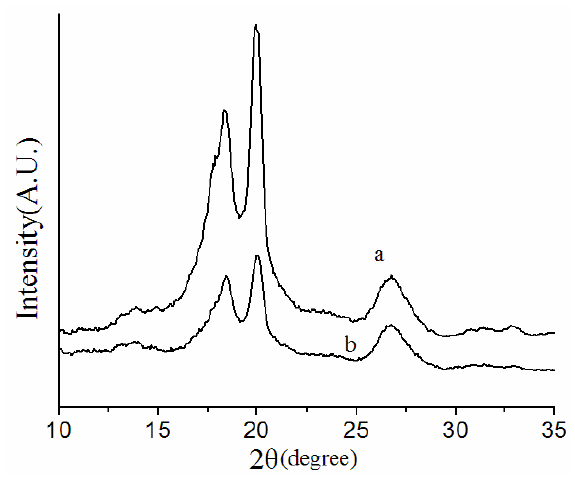
Figure 3. X-ray diffraction (XRD) patterns of ( a ) NIPS membrane; ( b ) melt spinning membrane.